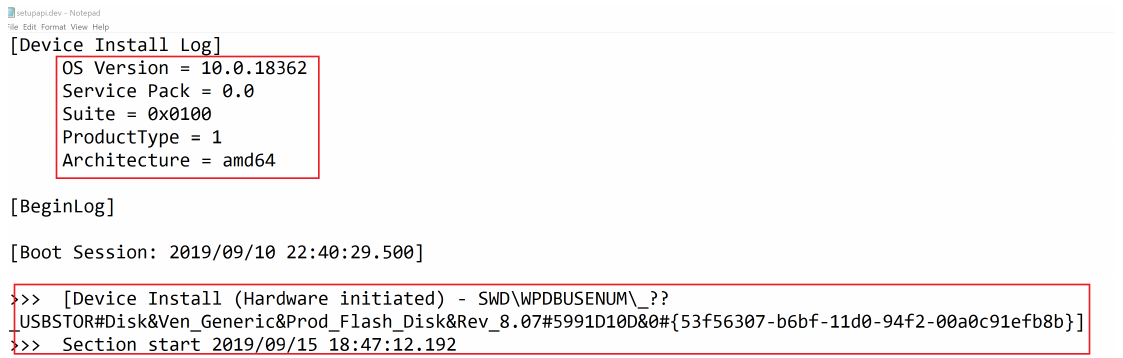
Figure 19. Generic USB setup information in setupapi.dev log